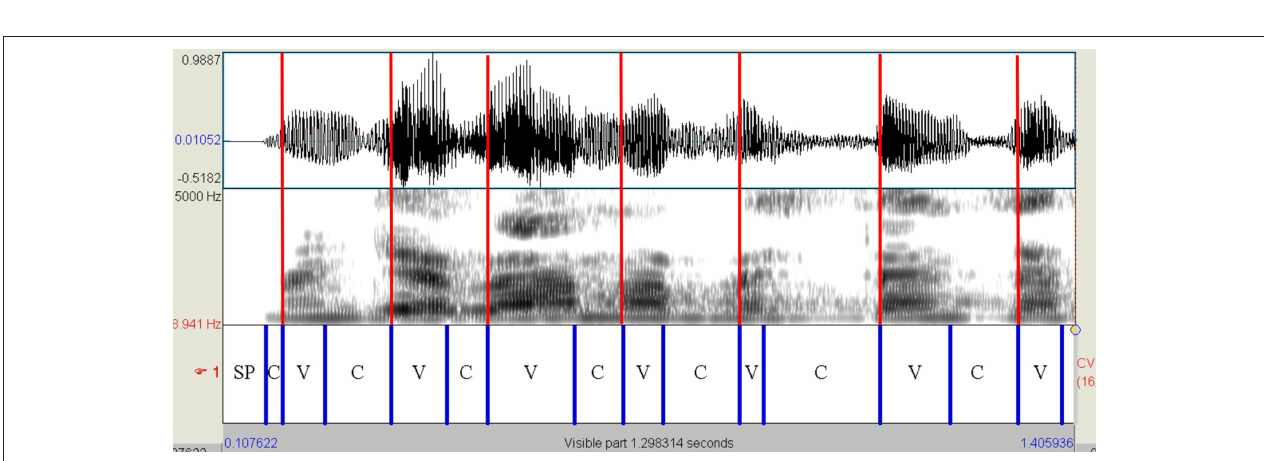
FIGURE 2 | Spectrogram of the utterance “ mangiavamo abbastanza ” (PD female voice—read speech). Red lines are placed in correspondence with the VOPs. The first and penultimate vowels [a] are followed by the nasal consonant [n]. In both cases, the V interval includes the nasalized part of the vowel. PD, Parkinson’s disease; C, consonantal interval; V, vocalic interval; SP, silent pause; VOPs, vowel onset points.